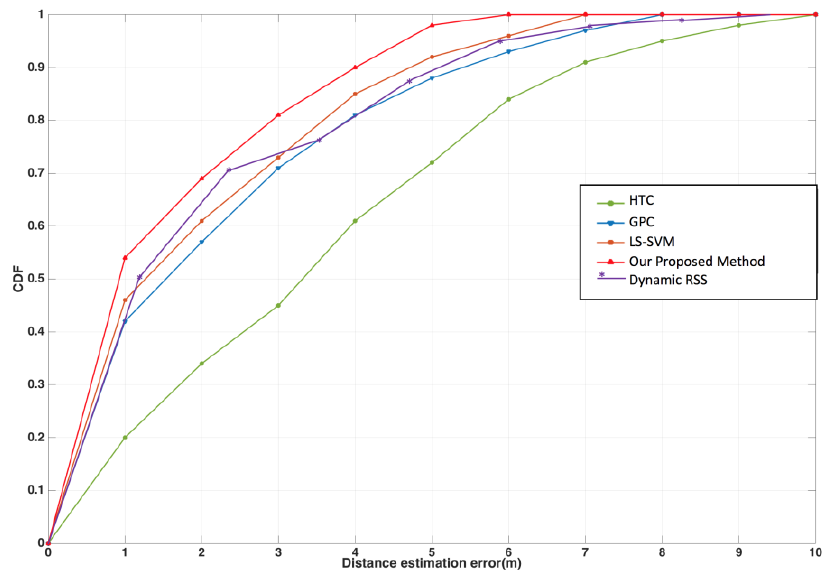
Figure 12. The comparisons with different Machine Learning methods.